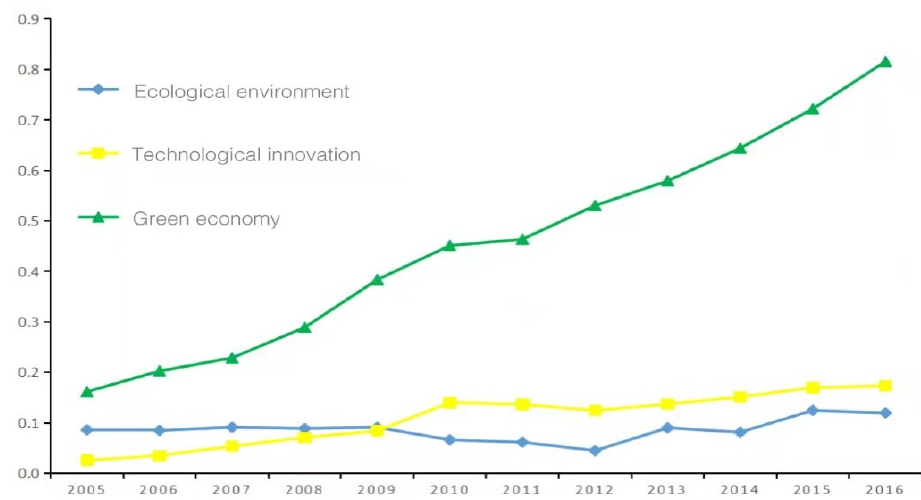
Figure 1. Comprehensive development levels of EE, TI, and GE (2005–2016).